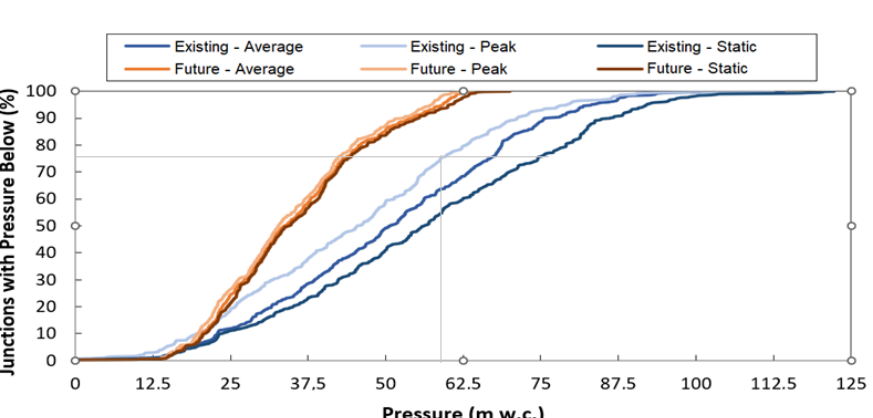
Figure 14. DT simulations present the percentage of nodes with the pressure